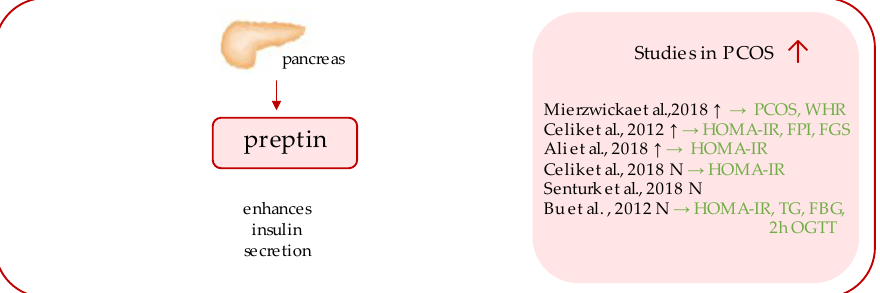
Figure 2. Role of preptin in the pathogenesis of insulin resistance and PCOS. List of the studies assessing serum nesfatin level in the PCOS patients. ↑ /N indicates whether concentration level of serum preptin was increased/unchanged in PCOS individuals ( p < 0.05); → (green)—indicates positive correlation between serum nesfatin and particular indicators; PCOS—polycystic ovarian syndrome; WHR—waist-to-hip ratio; HOMA-IR—Homeostatic Model Assessment for Insulin Resistance; FPI—fasting plasma insulin; FGS—Ferriman–Gallwey score; TG—triglycerides; FBG—fasting blood glucose; OGTT—oral glucose tolerance test.